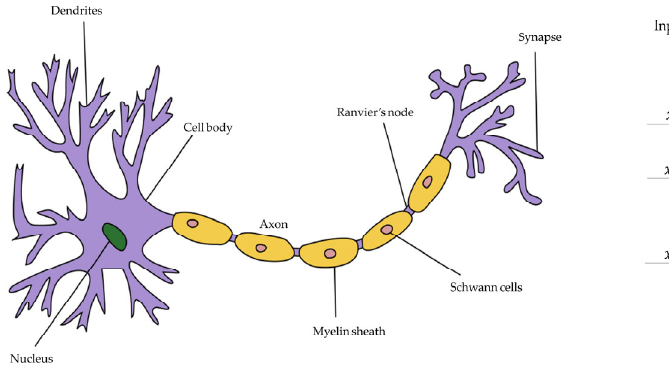
Figure 2. Dendrite module.